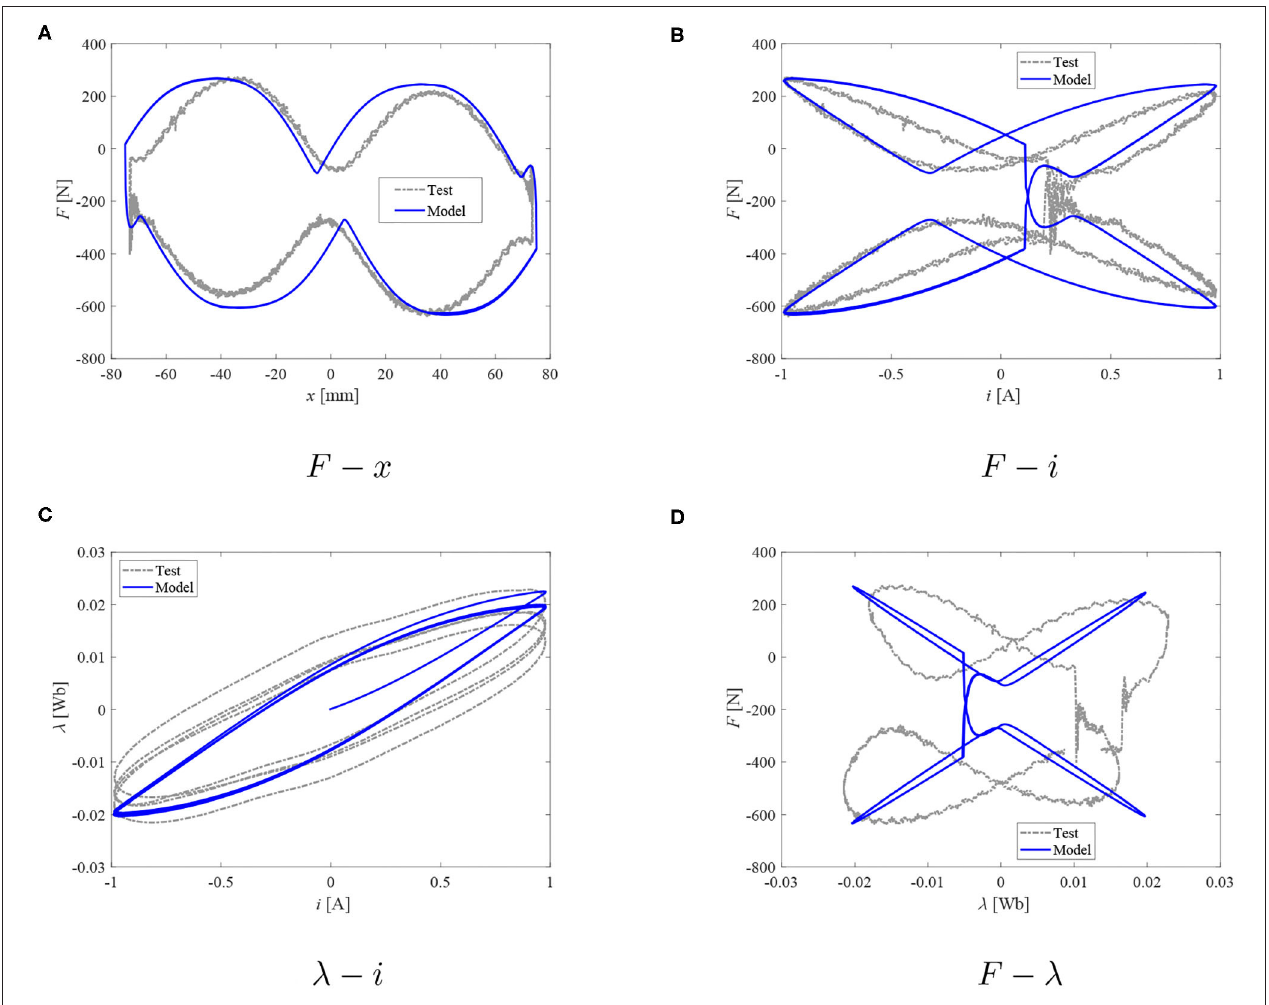
FIGURE 8 | Damper model: measured force and reconstructed flux vs. model data; peak current I = 1.0 A. (A) F − x . (B) F − i . (C) λ − i . (D) F − λ . parameter b 2 of the hyperbolic tangent function can be